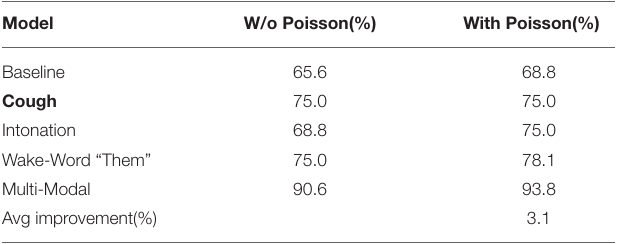
TABLE 2 | Impact of Poisson mask on AD